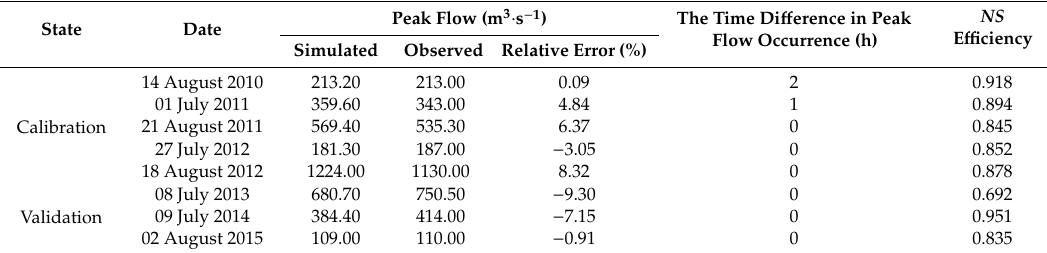
Table 5. The results of the flood simulation.